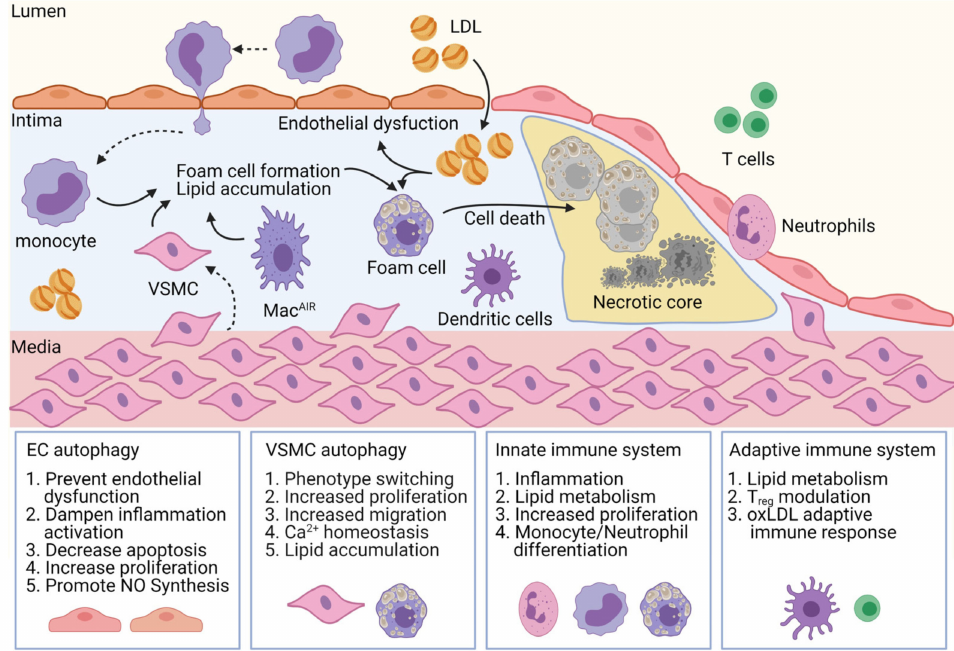
Figure 1. Cell-specific contribution of autophagy in atherogenesis. Autophagy governs homeostasis of cell types involved in all stages of atherogenesis. In endothelial cells (ECs), autophagy enhances nitric oxide (NO) bioavailability and prevents endothelial dysfunction and inflammatory activation, for example by lowering expression of adhesion molecules such as ICAM-1, VCAM-1, and PECAM-1. Autophagy regulates proliferation and migration of vascular smooth-muscle cells (VSMCs), contributes to their phenotypic switch, and regulates their lipid metabolism. Finally, autophagy machinery is involved in immune cell differentiation, proliferation, and lipid metabolism. Moreover, by affecting the adaptive immune system, it also contributes to the immune response to oxLDL epitopes and differentiation of T-cell subsets. LDL, low-density lipoproteins; Mac AIR , aortic intimal resident